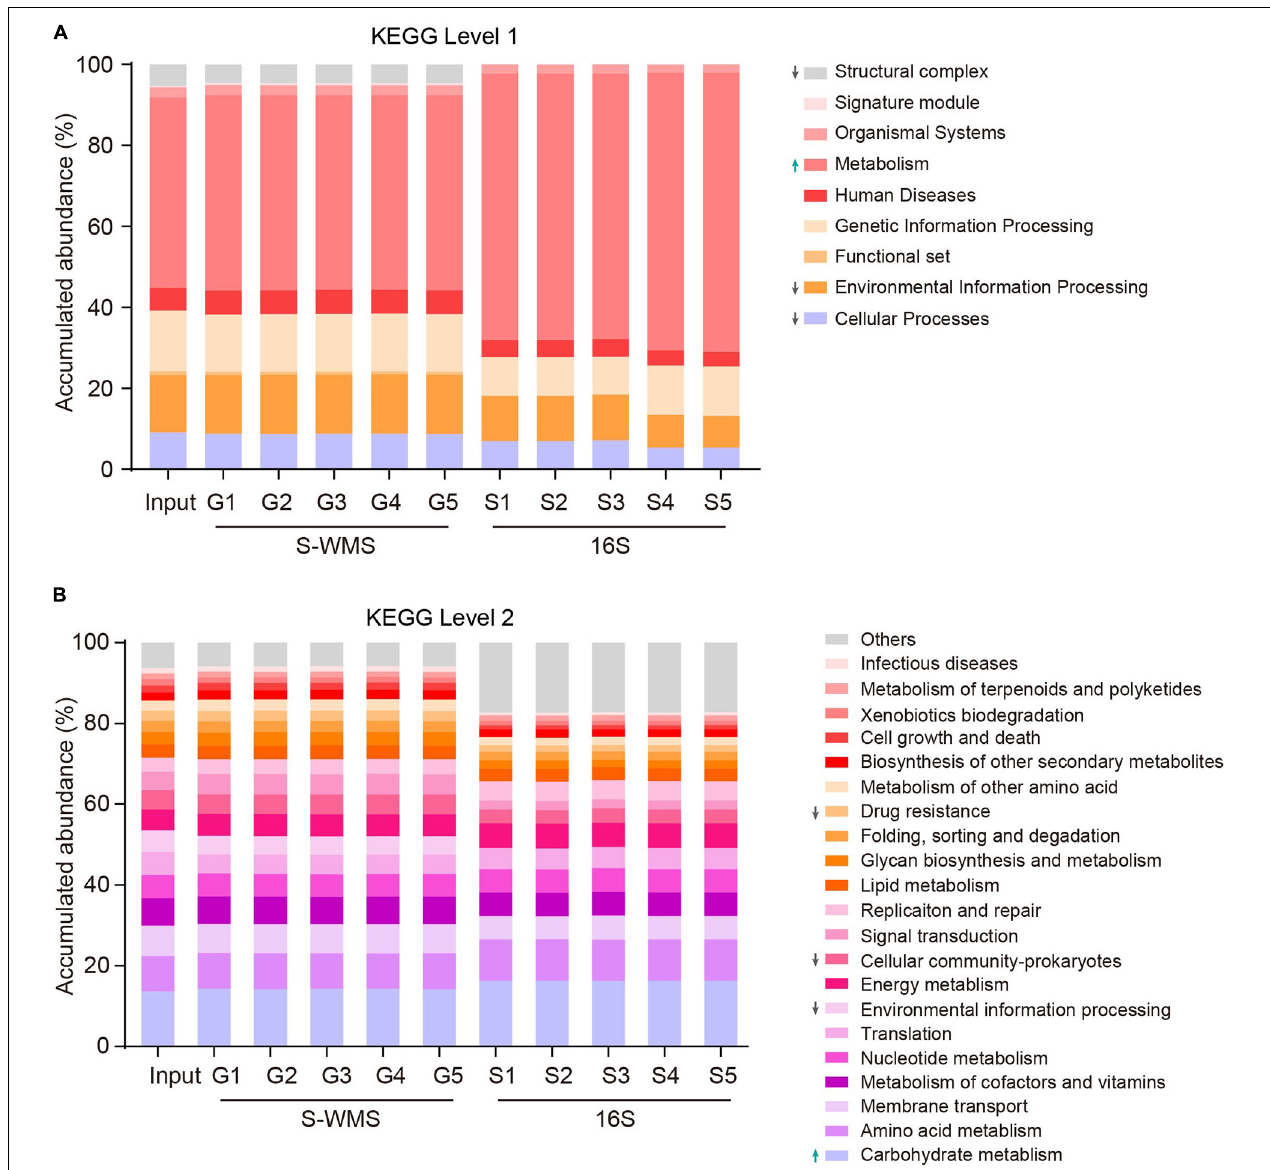
FIGURE 6 | The functional repertoire prediction of MOCK2 by S-WMS and16S sequencing methods at KEGG levels 1 (A) and 2 (B)